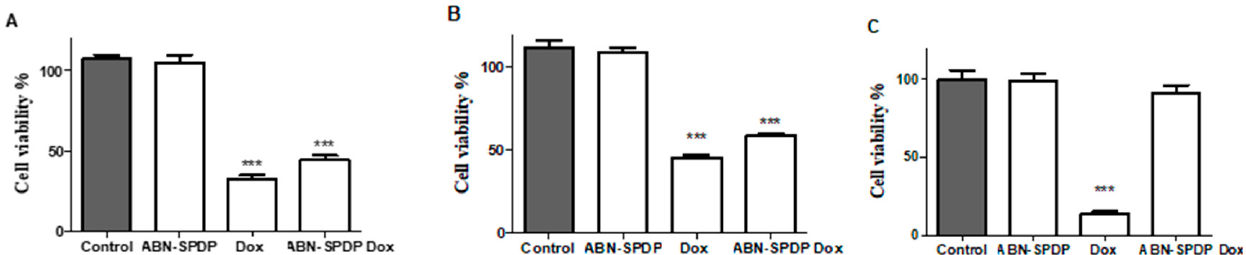
Figure 7. Cell viability assay with Dox-loaded ABN-SPDP 48 h post-treatment in ( A )MCF-7 cells, ( B ) MDA-MB-231, and ( C ) MCF-10 A. In all the cases, the concentration of Dox used was 2 µM. Statistical analysis was performed using one-way ANOVA Tukey’s test (*** p -value < 0.0001).